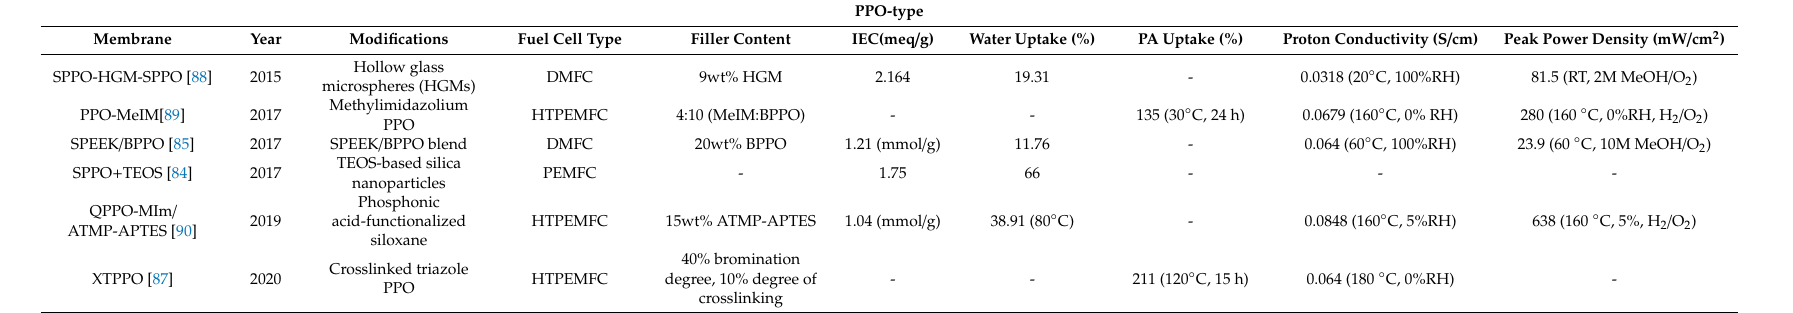
Table 7. Water uptake, PA uptake, and the electrochemical properties of PPO-type PEMs.